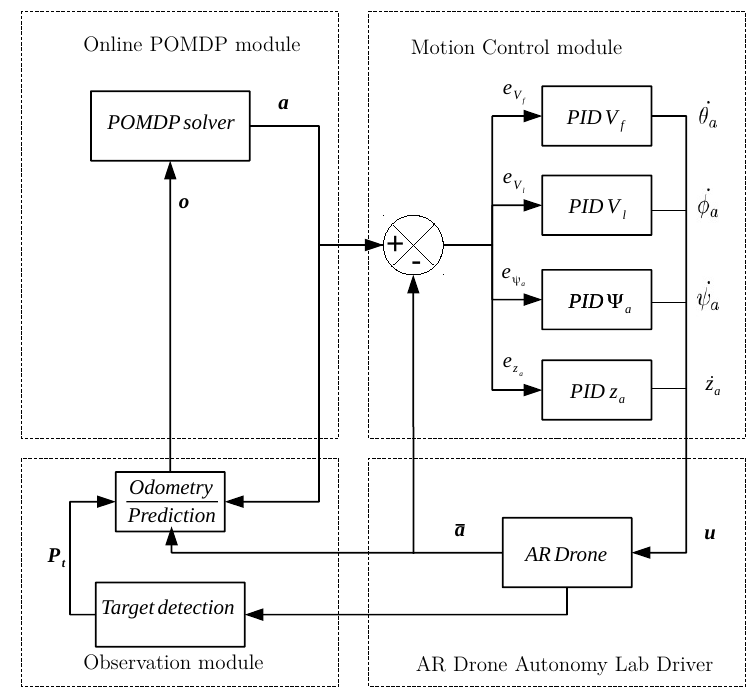
Figure 1. POMDP ROS system